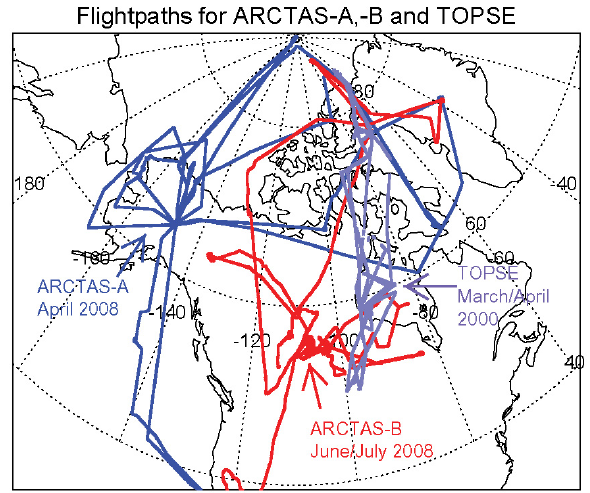
Fig. 1. Flight paths for the NASA DC-8 during ARCTAS-A and -B, and for the NCAR C-130 during TOPSE-sp (subset of TOPSE data obtained during March and April and north of 50 ◦